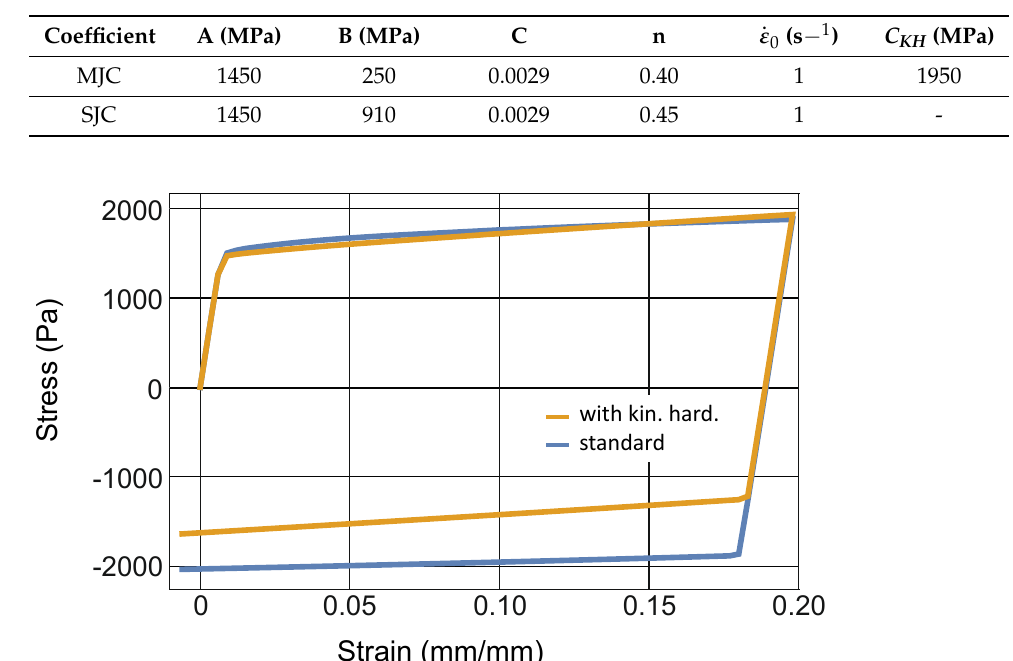
Figure 3. Stress-strain curves in a tension-compression test up to 20% nominal strain for two parameter sets given in Table 1, one without kinematic hardening and one with a considerable kinematic hardening part. Table 1. Johnson-Cook constitutive model coefficient for AISI 4140 [20,21].